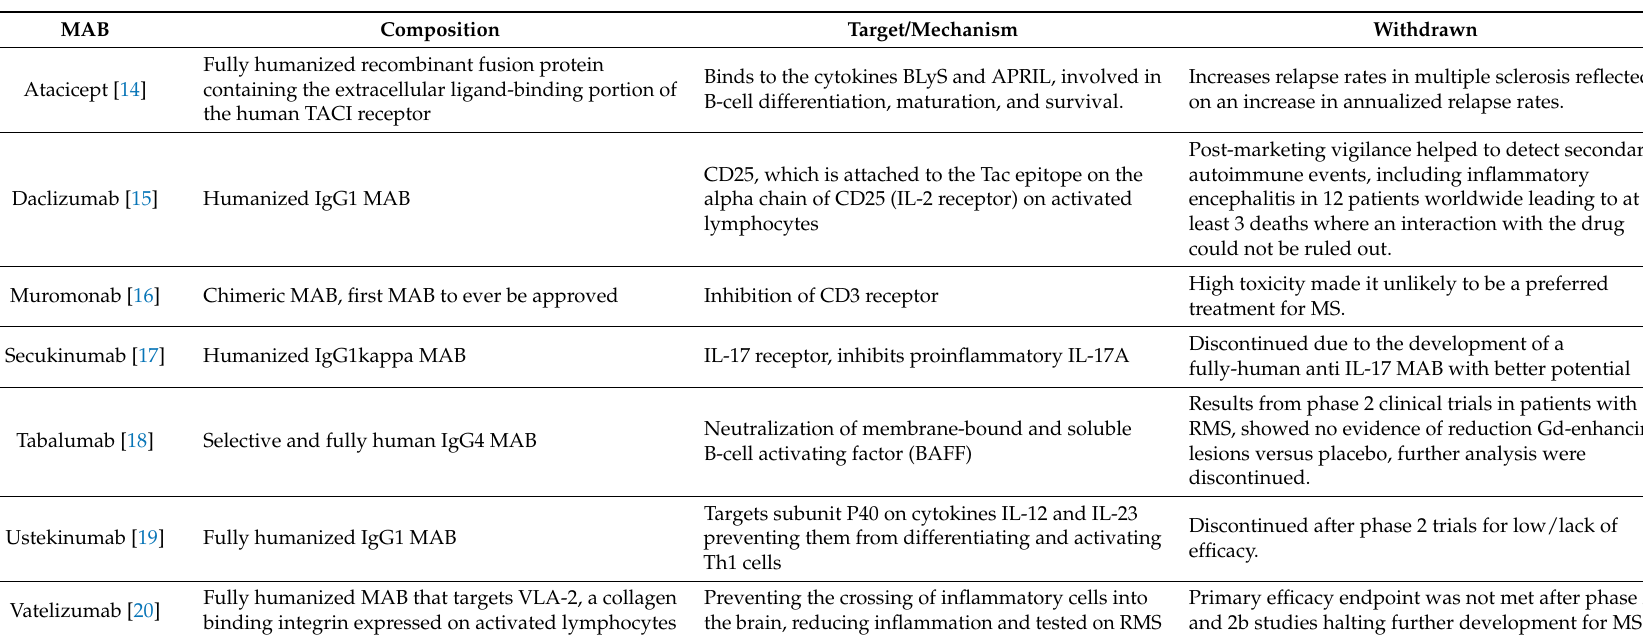
Table 2. Examples of MAB therapies that have been discontinued from further clinical trials due to lack of efficacy or serious adverse events in the treatment of multiple